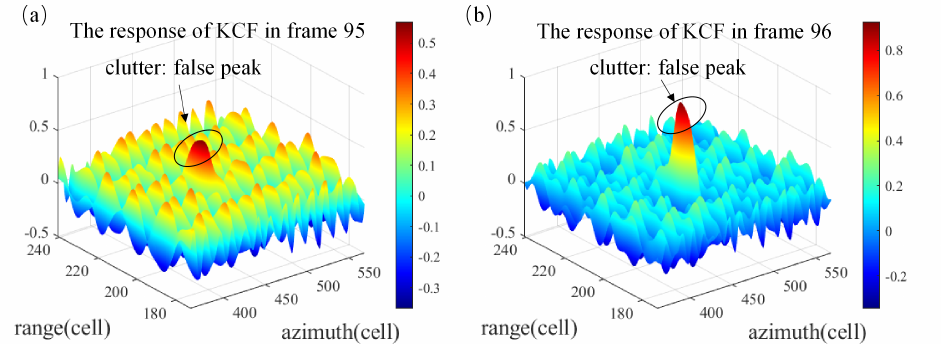
Figure 10. The response maps of KCF (target 2 in frame 95 and frame 96). ( a ) The response maps in frame 95. ( b ) The response maps in frame 96.